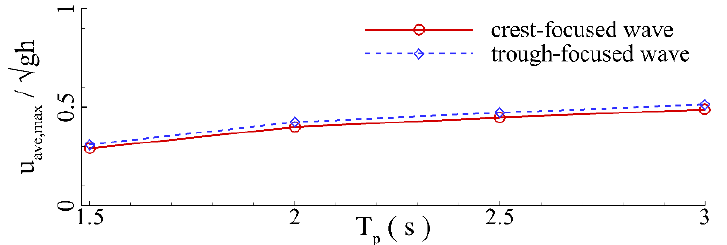
Figure 30. Local maximum depth-averaged velocity at the reef crest versus the peak wave period.